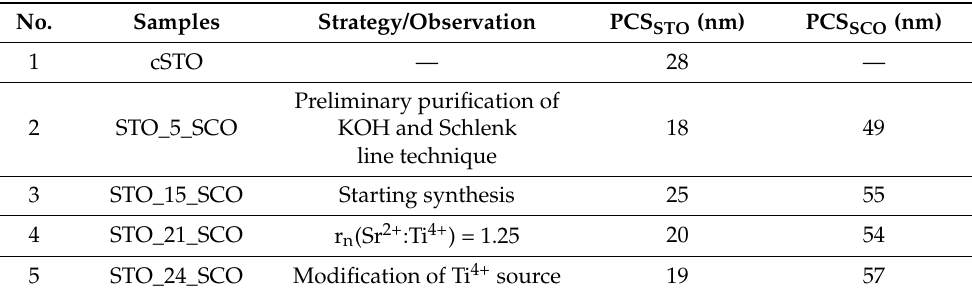
Figure 1. Powder X-ray diffraction pattern of the studied catalysts. Table 1. Summary of the applied strategy aiming for the control of SrCO 3 content and the primary crystallite size (PCS) of components for all tested photocatalysts (STO_x_SCO, x = 5, 15, 21, and 24